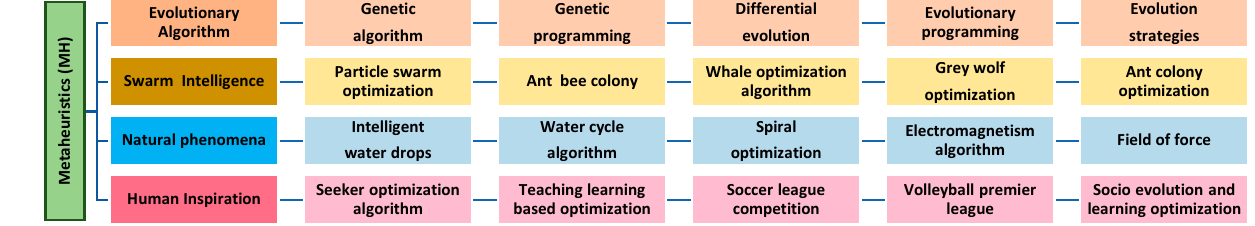
Figure 2. The different categories of MOAs.